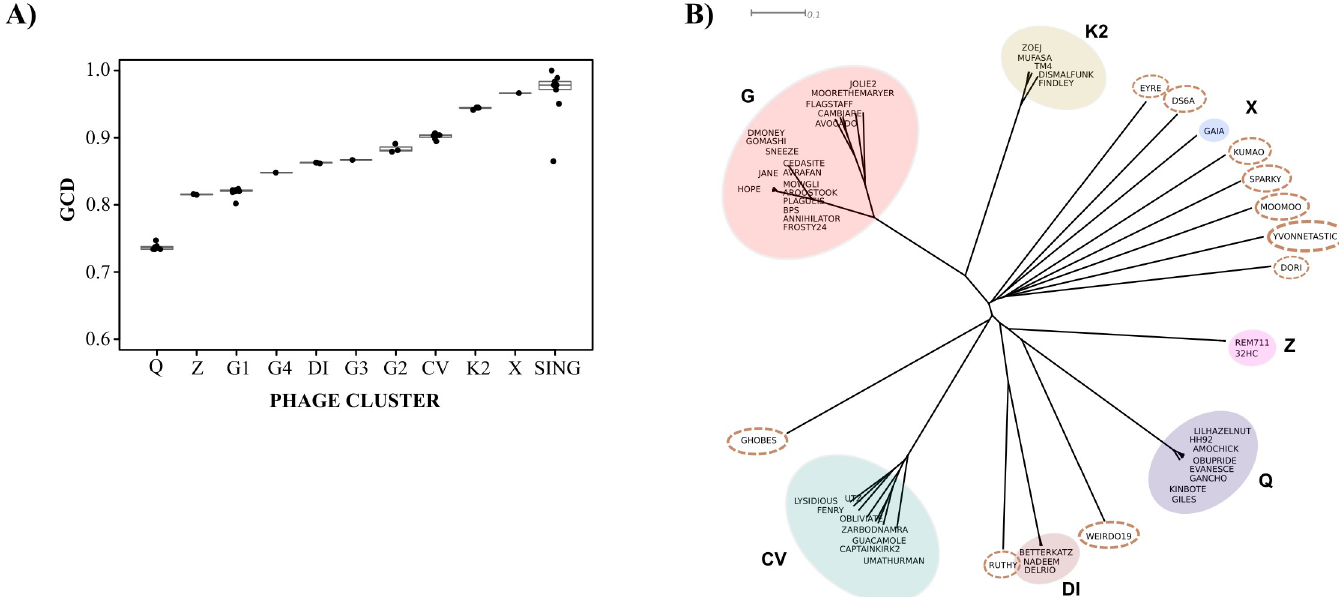
Fig 7. Gene content dissimilarity (GCD) analysis. A) Boxplot of the GCD values of 54 bacteriophages against Weirdo19ES. As shown in picture, cluster Q are sharing more genes with Weirdo19ES, represented by the lower values of GCD. B) EqualAngle algorithm was used to build a phylogenetic network in Splitstree 4 with the GCD values of all bacteriophages in the analysis. The different clusters were colored whereas singletons are in dotted boxes.